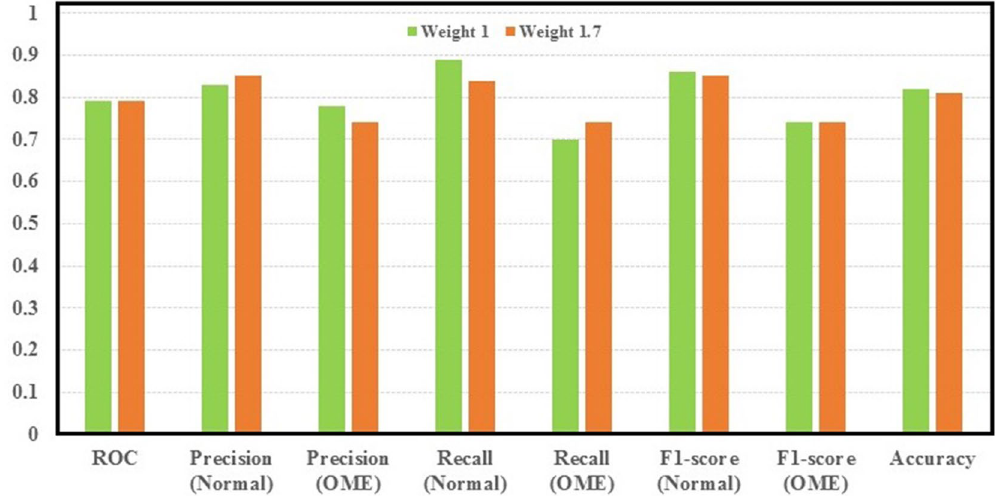
Figure 3. Performance of CNN2 with using different weights on the OME samples in the cost function.